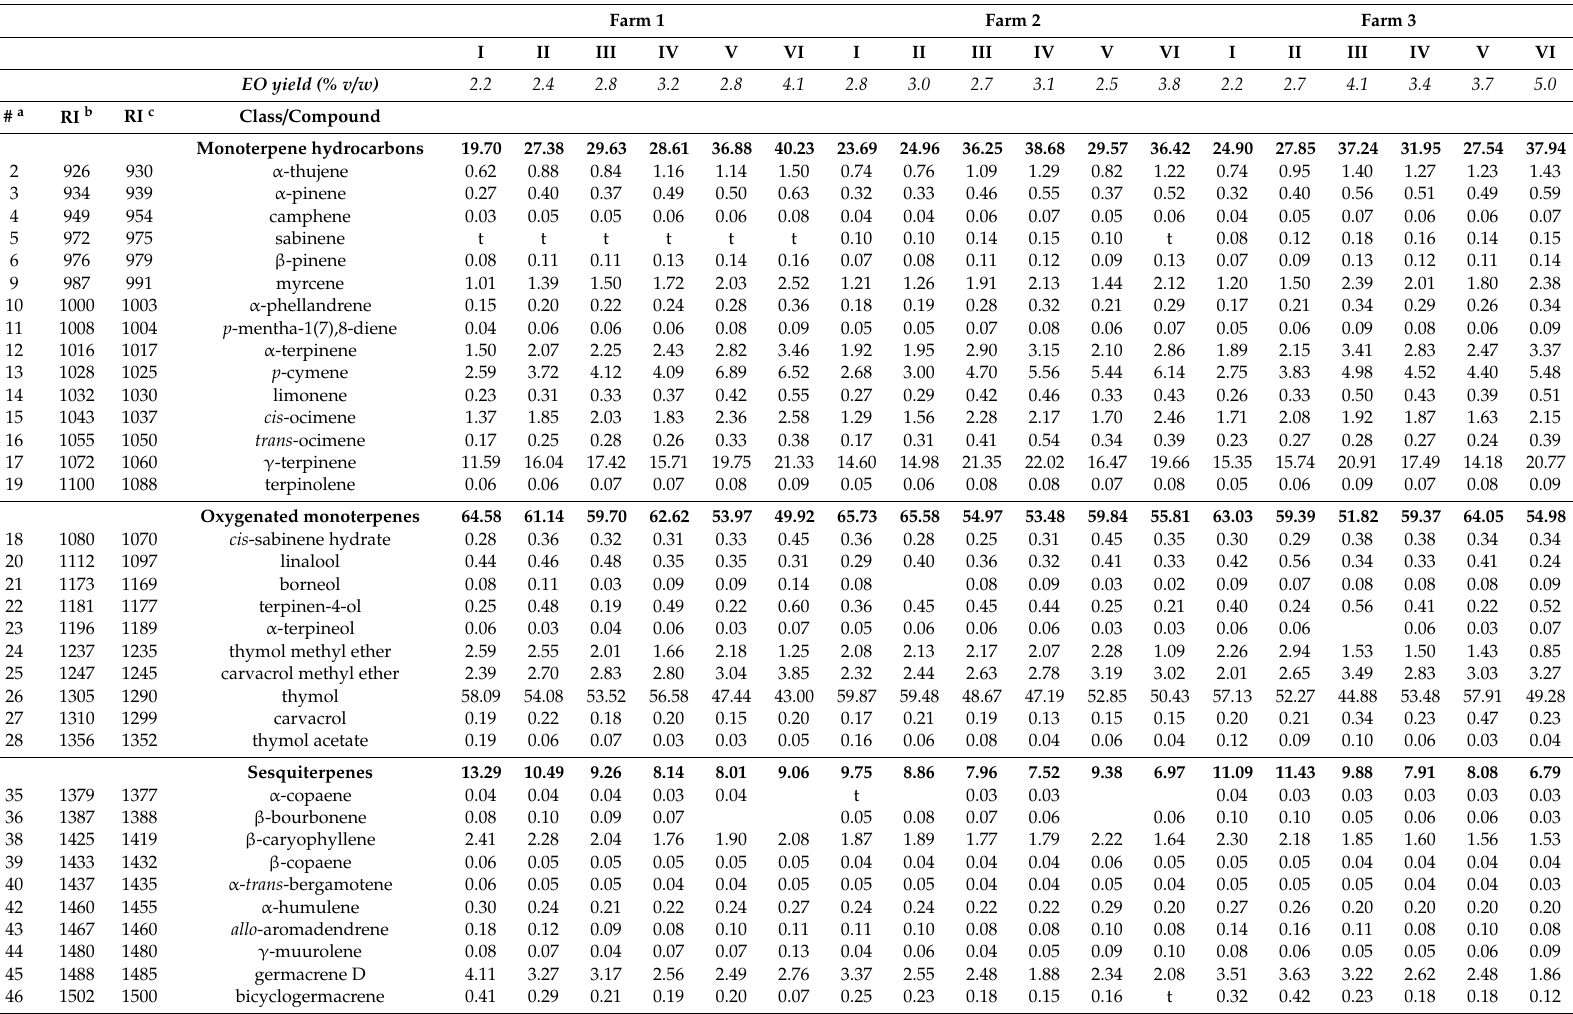
Table 2. Origanum heracleoticum . 2014. EO yield and composition (relative peak area percent) in plants cultivated in 3 Sicilian farms (1 to 3) in 6 harvest times (I to